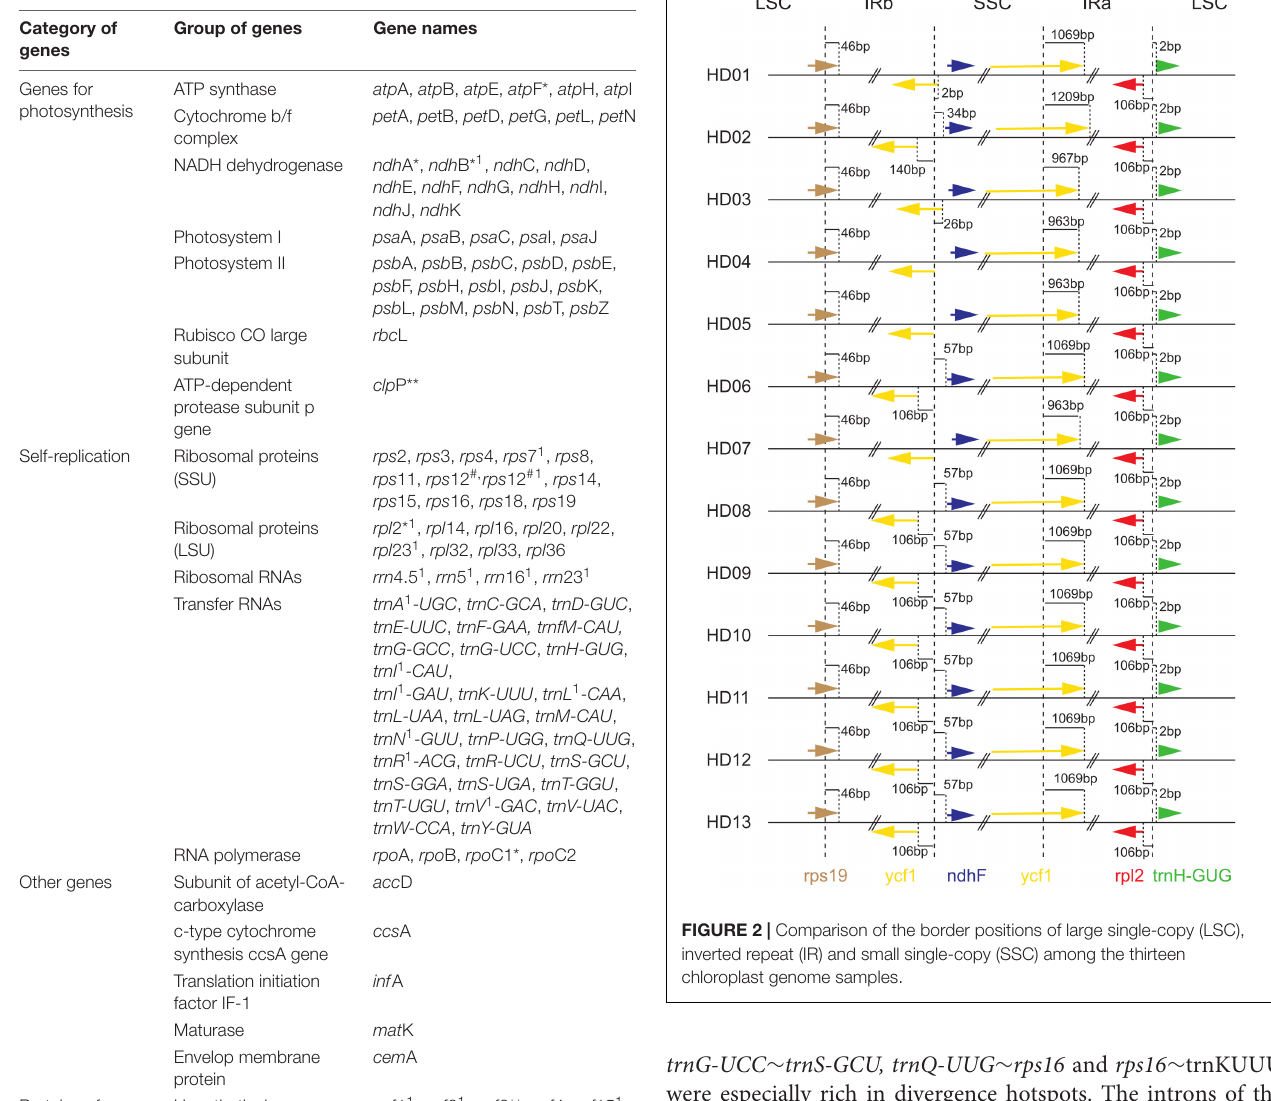
TABLE 4 | List of genes found in 13 chloroplast genome samples.